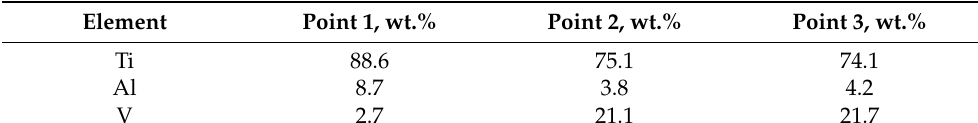
Table 2. Elemental compositions of the EBAM Ti-6Al-4V samples produced without substrate cooling. EDX data were obtained at the points indicated in Figure 4a. Element Point 1, wt.%